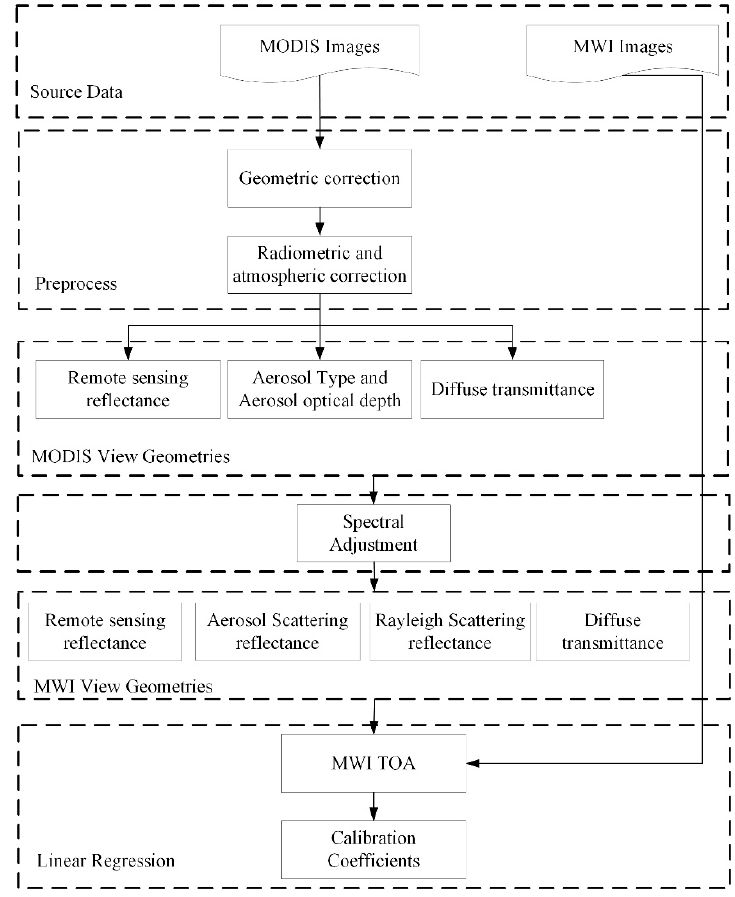
Figure 3 . Flowchart of the cross ‐ calibration of MWI using MODIS images. Note: TOA, Top of Figure 3. Flowchart of the cross-calibration of MWI using MODIS images. Note: TOA, Top of Atmosphere. Atmosphere. Table 3. Spectral adjustment factors between MWI and